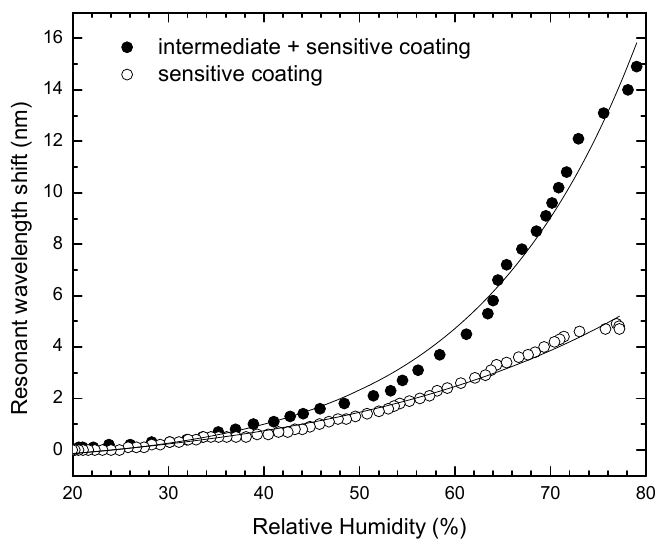
Figure 6. Resonant wavelength shift dependence with relative humidity for both